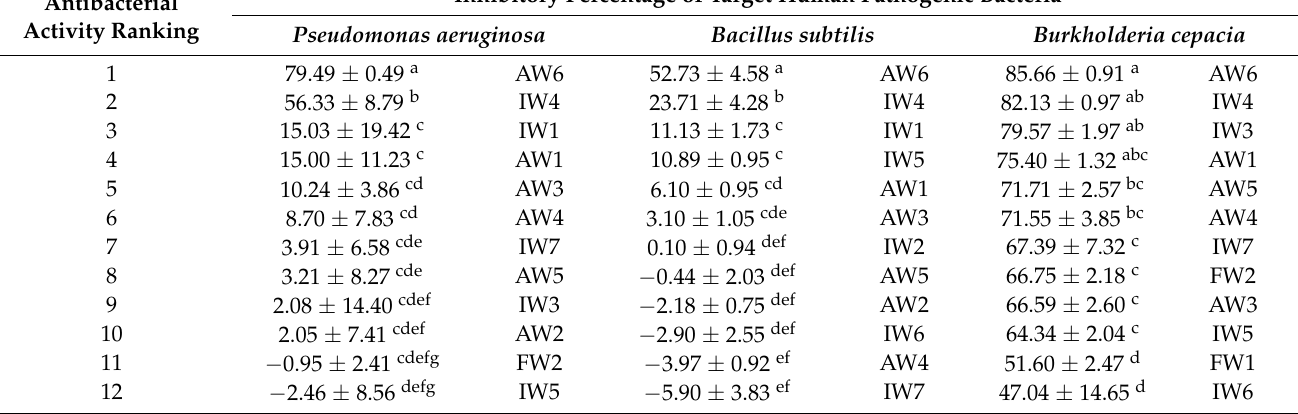
Table 1. Ranking of inhibitory percentage of lower 3 kDa hydrolysate samples against human pathogenic bacterial growth at 6 h after